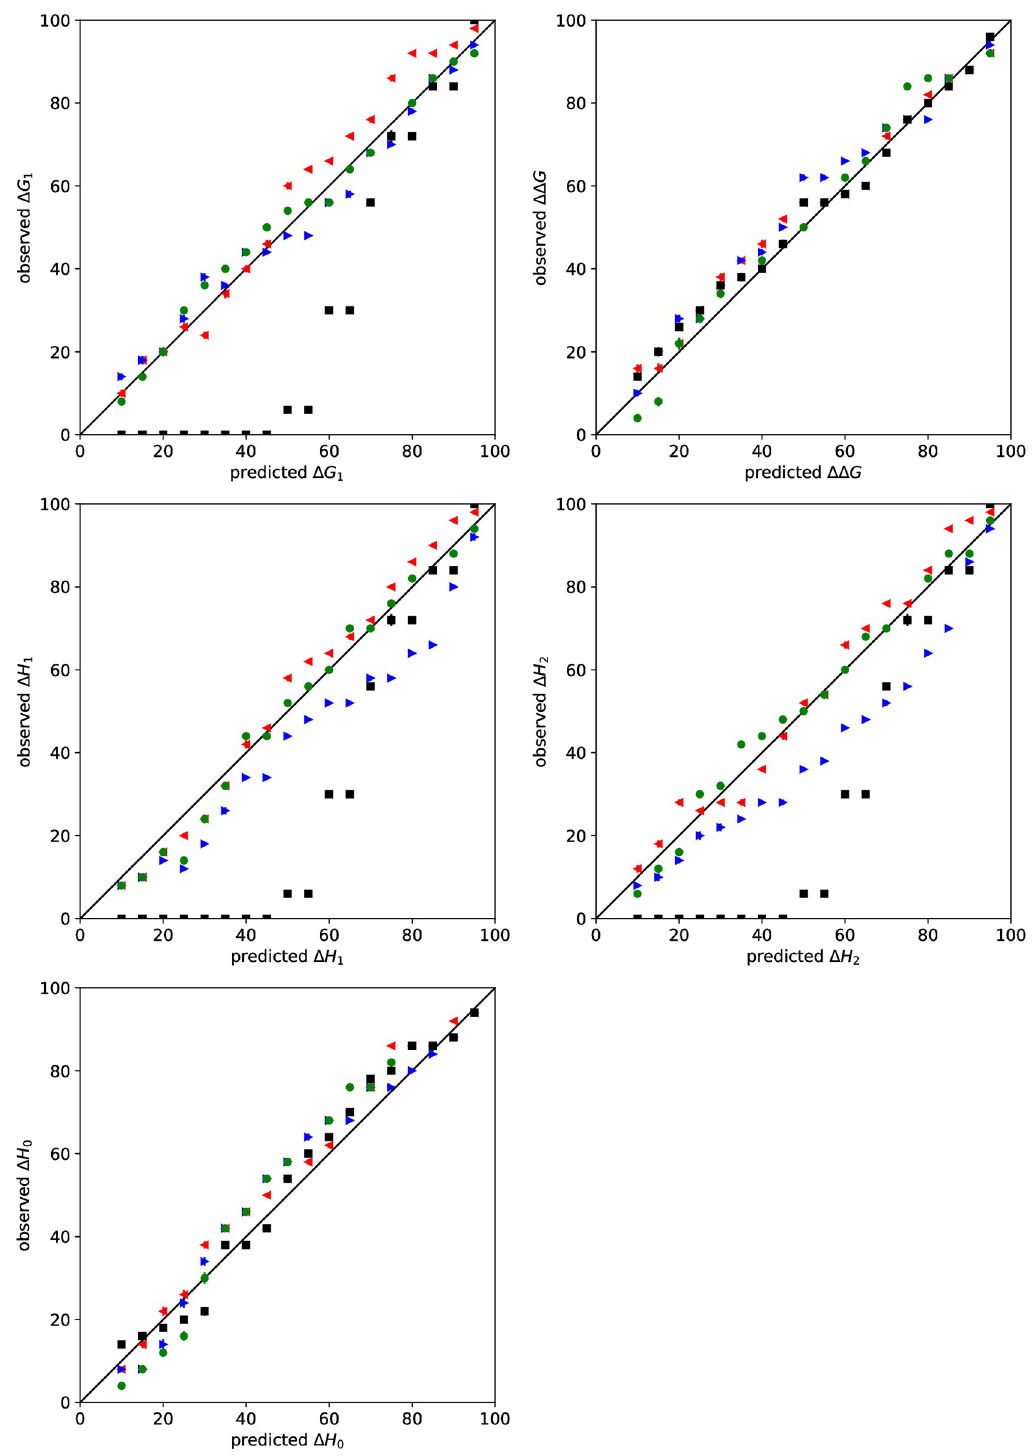
Fig 4. Uncertainty validation for Bayesian analysis of simulated data. The predicted versus observed rate (%) in which BCIs contain the true value for binding parameters are shown. Priors for the concentration were lognormal for both [ L ] s and [ R ] 0 (red left triangle), lognormal for [ L ] and uniform for [ R ] 0 (green circle), uniform for [ L ] and lognormal for [ R ] 0 (blue right s s triangle), or uniform for both [ L ] s and uniform for [ R ] 0 (black square). Error bars are standard deviations based on bootstrapping of 1000